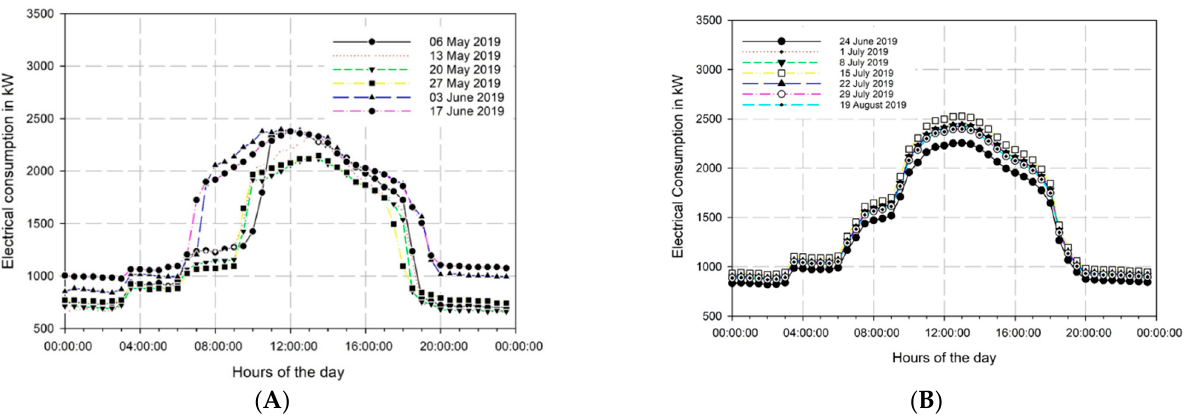
Figure 8. ( A ) Measured electrical consumption for Mondays in interval B from May to August 2019, and ( B ) estimated consumption for Mondays for the missing data in the same interval based on a linear correlation discussed in the text.